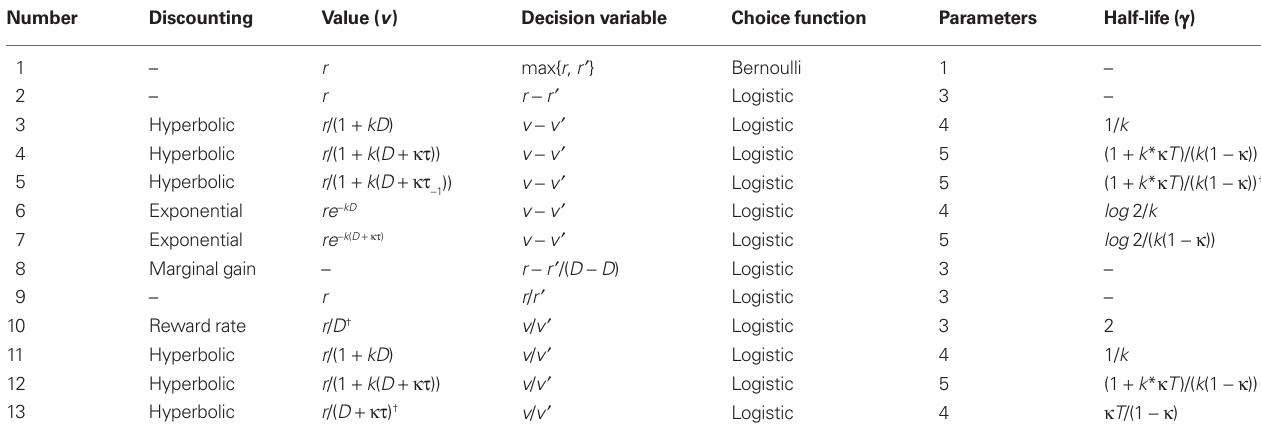
Table 2 | Model specifications for the 13 models